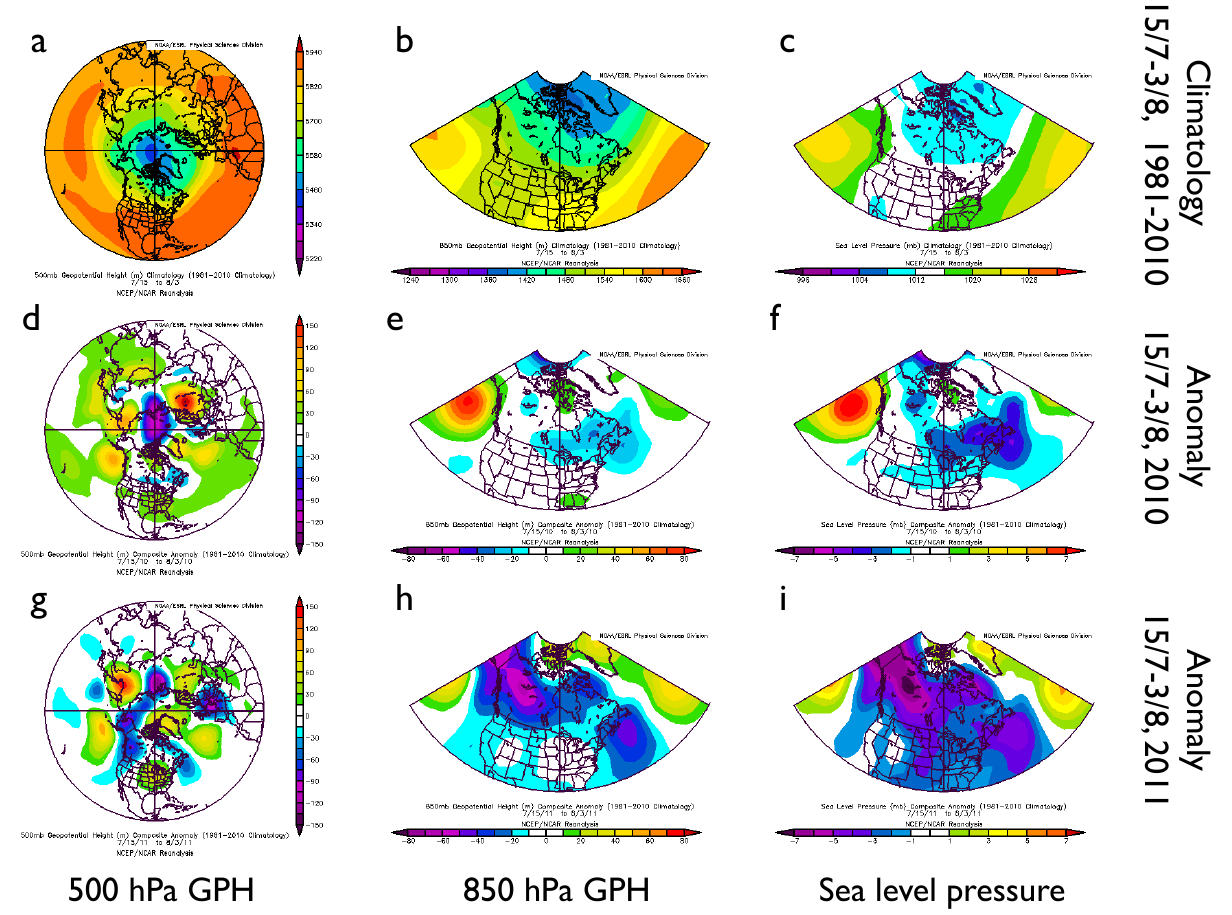
Fig. 5. Climatological mean 500hPa (a) and 850hPa (b) geopotential heights (GPH, expressed in metres, m) and sea level pressure (mb) (c) for 15 July–3 August for the period 1979–1995, and the corresponding departures from those means for 15 July–3 August 2010 (d–f) and for 15 July–3 August 2011 (g–i) . Image provided by the NOAA/ESRL Physical Science Division, Boulder, Colorado (http://www.esrl.noaa.